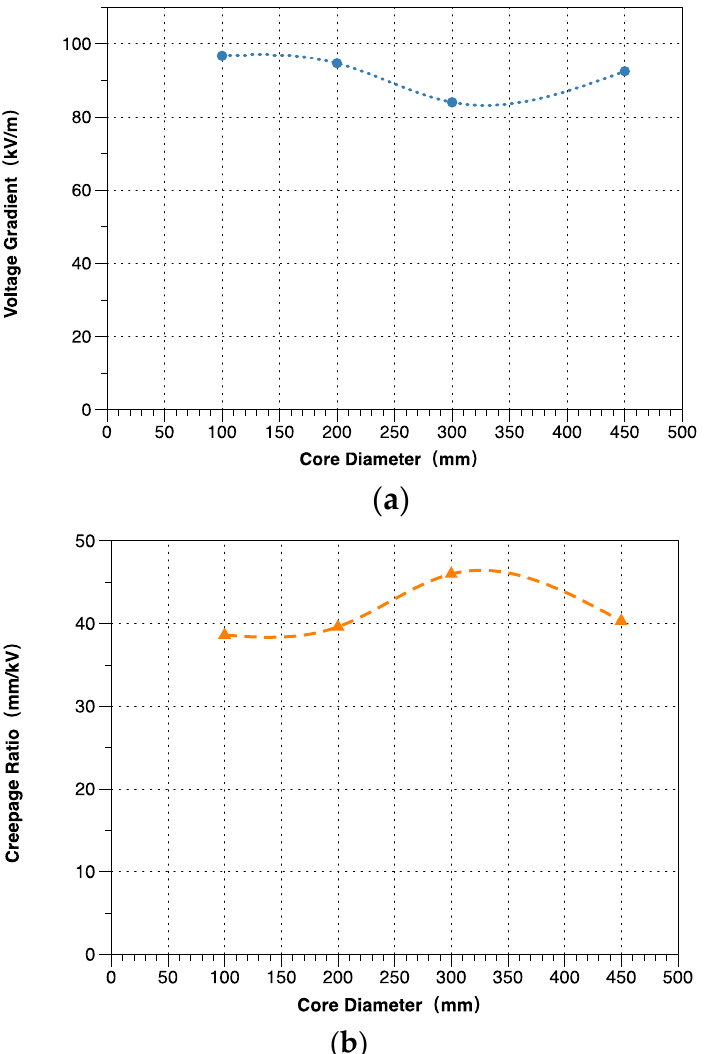
Figure 7. Results of pollution flashover tests: ( a ) Trends of voltage gradient and core diameter; ( b ) Trends of creepage ratio and core diameter.